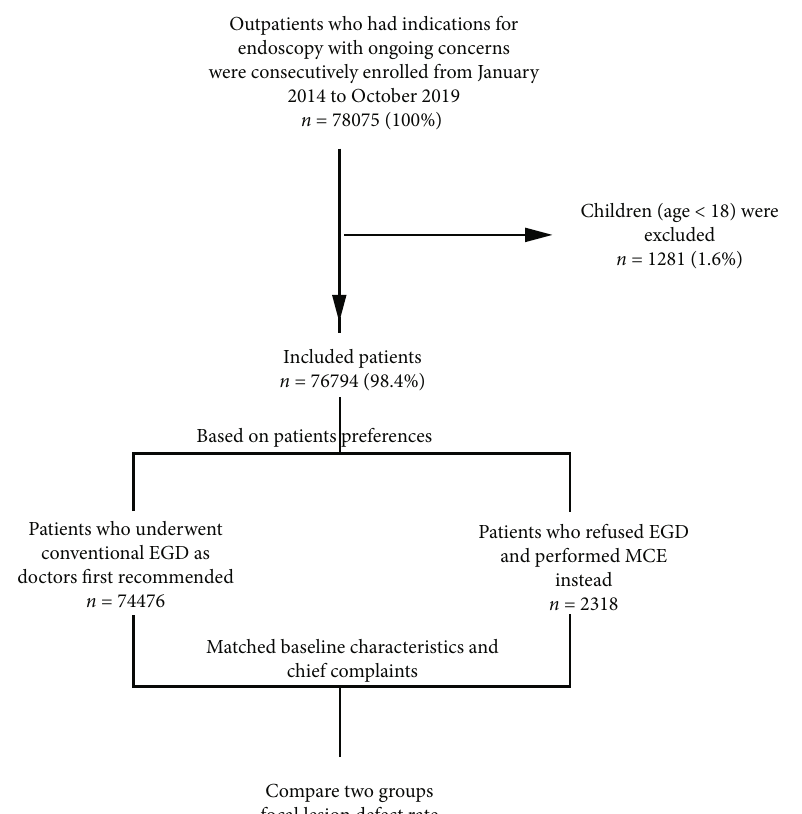
Figure 1: Study fl owchart. ∗ Children aged less than 18 years were enrolled in another MCCG study cohort in our